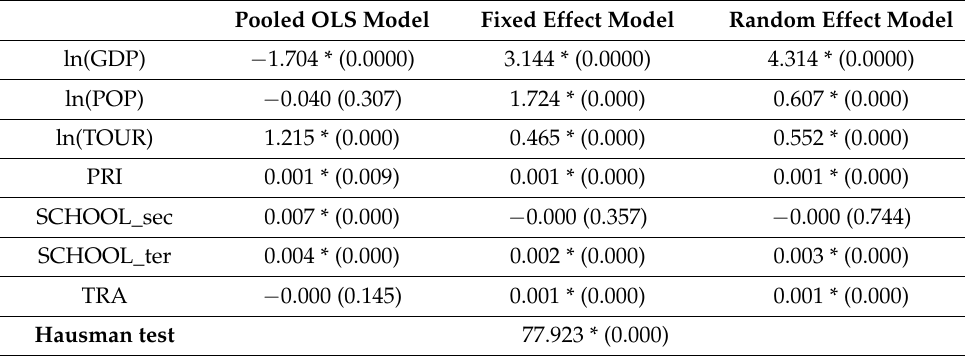
Table 3. Panel Data Regression